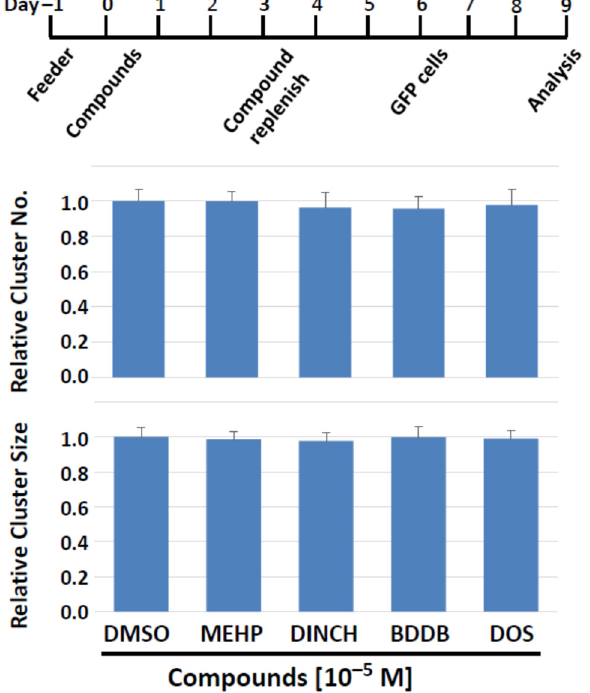
Figure 8. Feeder cells pretreatment with plasticizing compounds for 6 days can still support normal cluster forming activity. ( Top ) The treatment schedule. On days 3 in vitro, media and compounds were replenished. Cluster cells were seeded on treated feeder cells on day 6, and their number and size were determined on day 9. ( Bottom ) Number and size of clusters. Feeder cells that experienced potentially negative effects of test compounds do not lose their ability to support cluster formation.